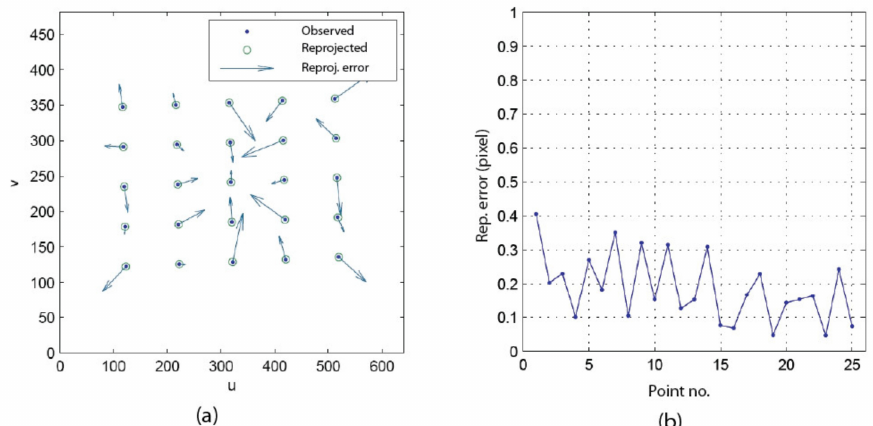
Figure 23. Result of the estimation of the pose of the virtual calibration target in the reference frame of the camera. The dots represent the observed position of 25 calibration points. The circles represent the position of the reprojection of the calibration points using the estimated pose. Since the error is very small, the arrows show the modulus and orientation of the reprojection error with an amplification factor ( a ). Quantitative value of the reprojection error for the 25 calibration points numbered from the right to left/top to bottom. The error is always smaller than 0.4 pixel ( b